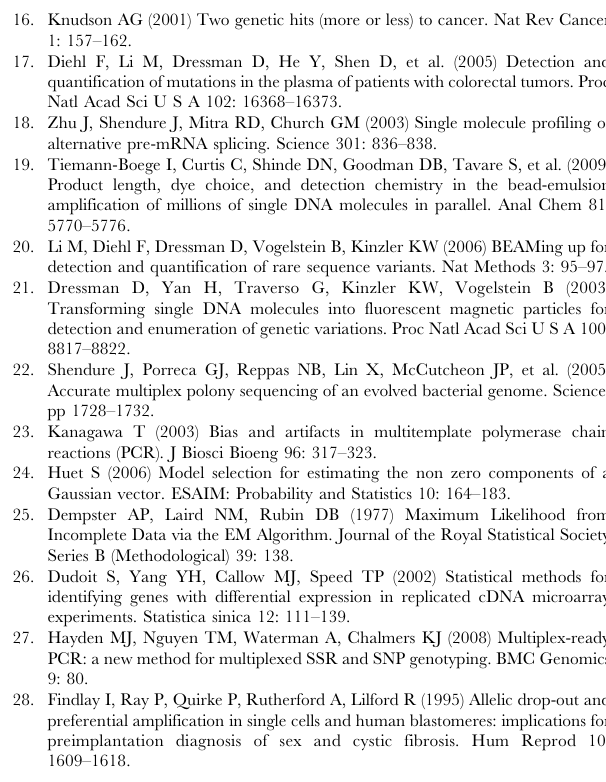
Table S1 Target loss measured in the amplification of two